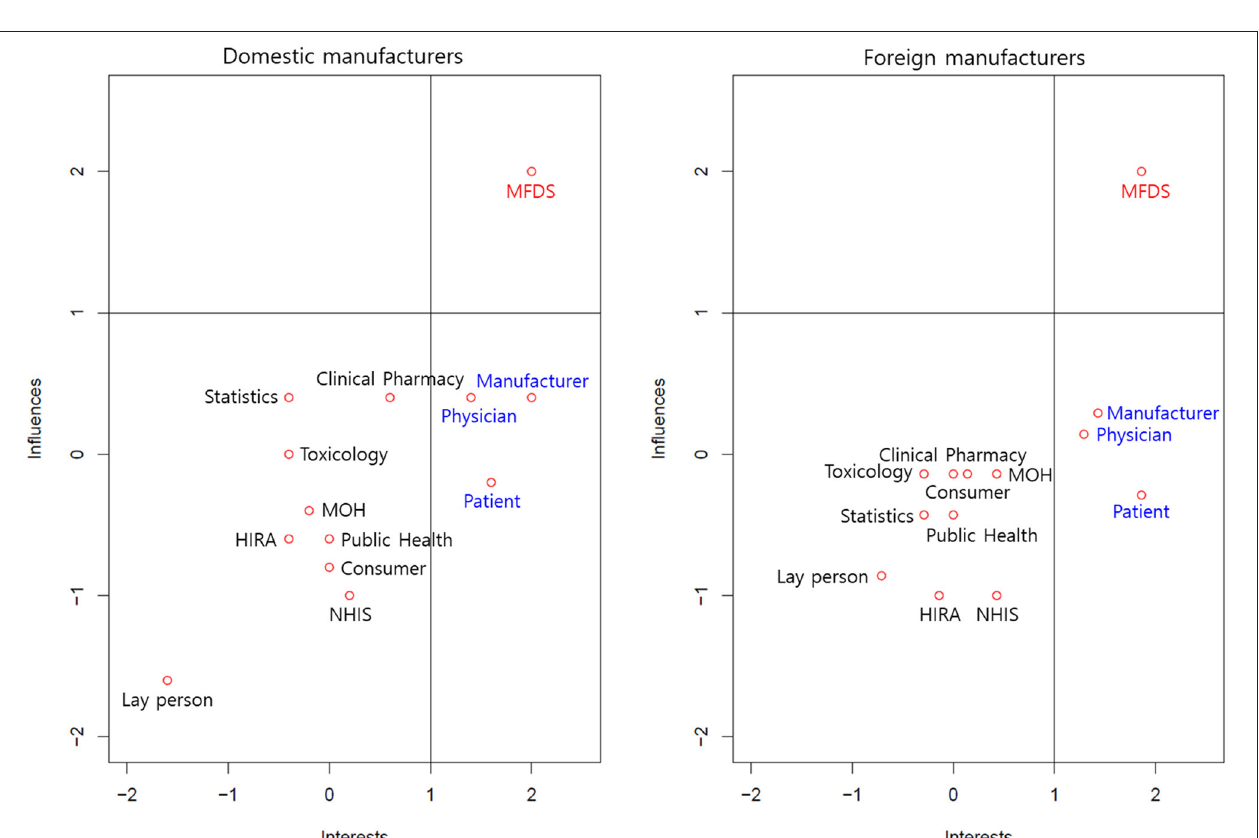
Results from this study could provide evidence on establishing new drugs